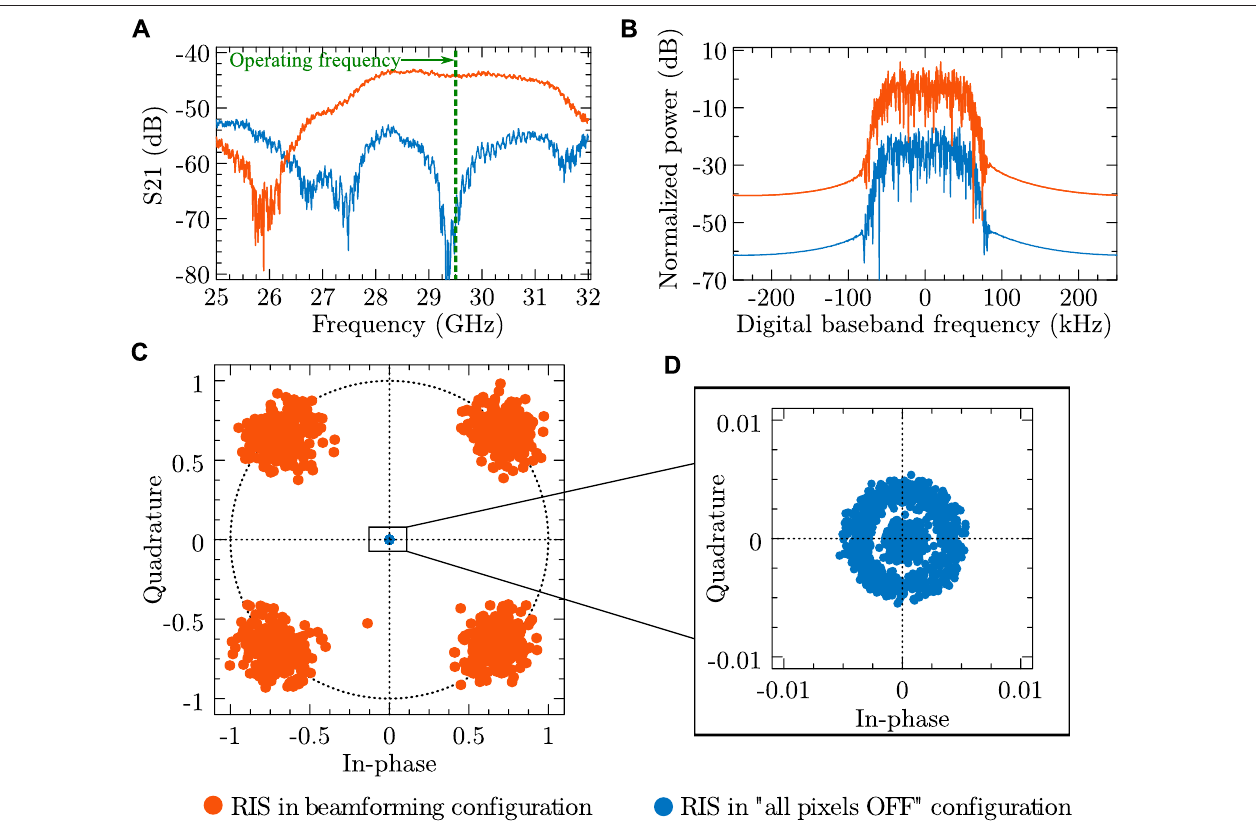
FIGURE4|(A) S21parameter measured withaVNA forchannel characterizationintwocon fi gurations oftheRIS:allpixelsoff and beamformingcon fi guration. (B) The signal received by the SDR and put through an RRC fi lter, when the RIS is off and on. (C) Constellation diagram after timing recovery, equalization and phase and frequency offset compensation, when the RIS is off and on. (D) Close-up of the constellation diagram when the RIS is off.